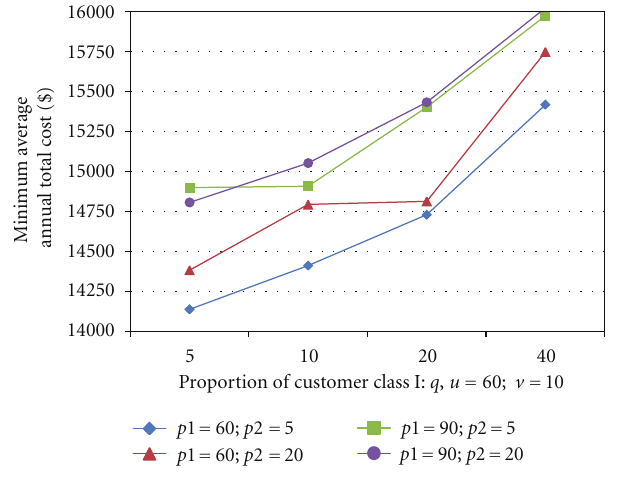
Figure 9: The impact of customer di ff erentiation on ATC under the disruption scenario of { u = 60; v = 10 }